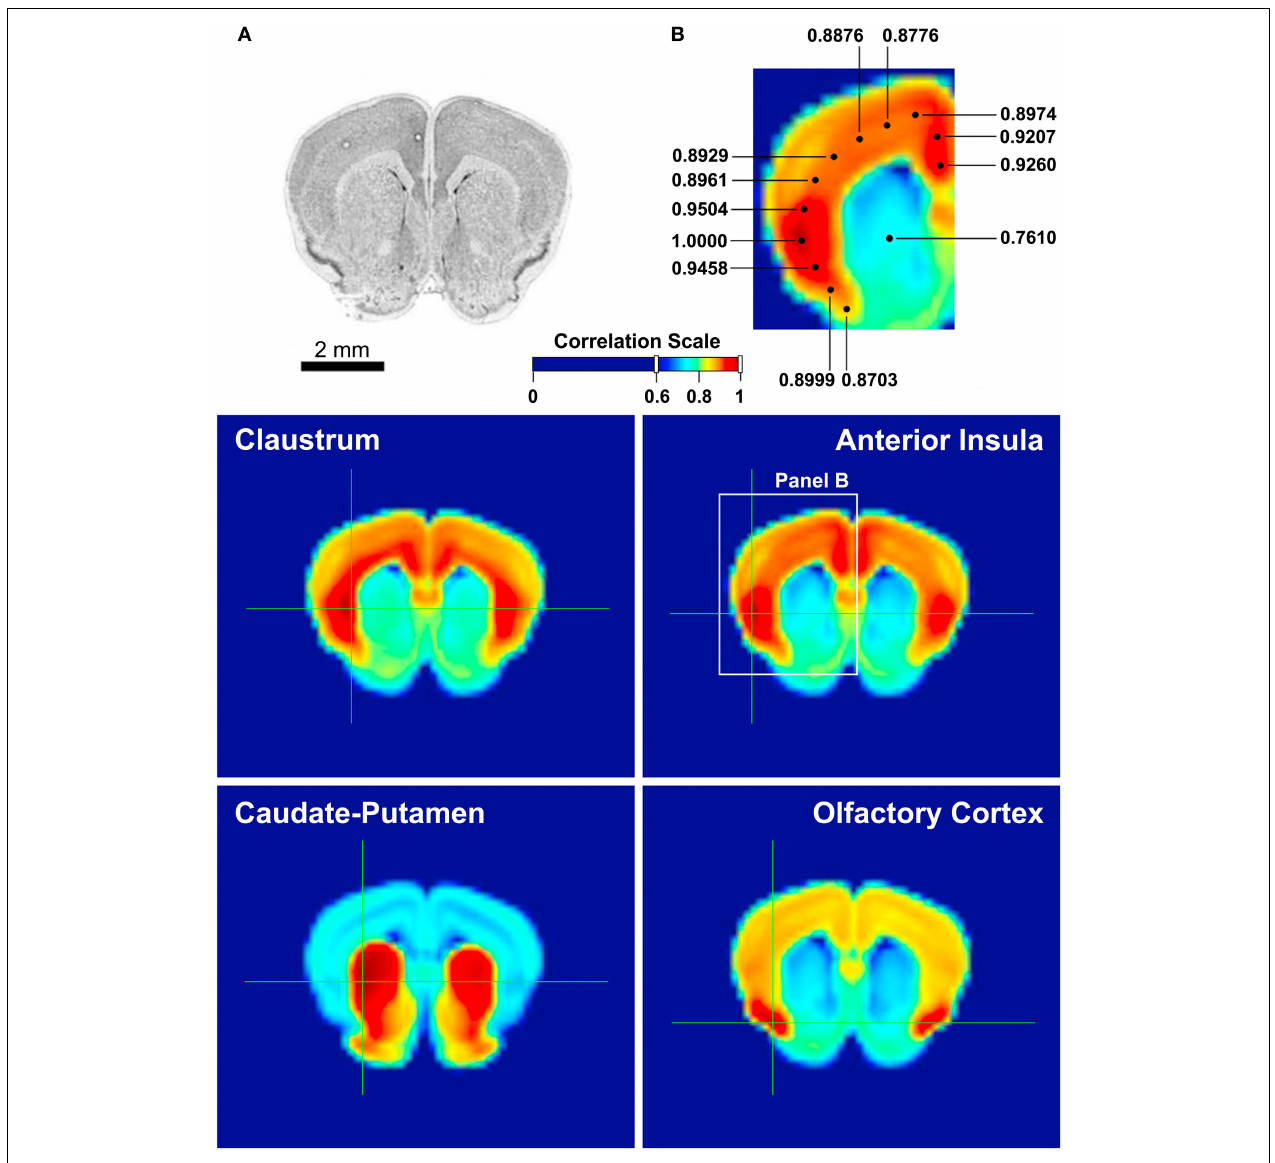
cortex. Each number indicates the degree of correlation between the selected area and the location of the dot connected with the number.The dot with the correlation value of 1.0000 is where the selection crosshair was placed. Middle left:The mouse claustrum’s gene expression correlation profile. According to the correlation scale [between ( A,B )], the claustrum is most strongly affiliated with the deep layers of the insular cortex. Middle right:The anterior insula’s gene expression is most highly correlated with the cingulate cortex, as well as itself. Bottom left:The caudate-putamen, besides a moderately high correlation with the olfactory tubercle, is mostly contained within itself. Bottom right:The olfactory cortex, other than the moderately high correlation with the cortex, is mostly correlated with